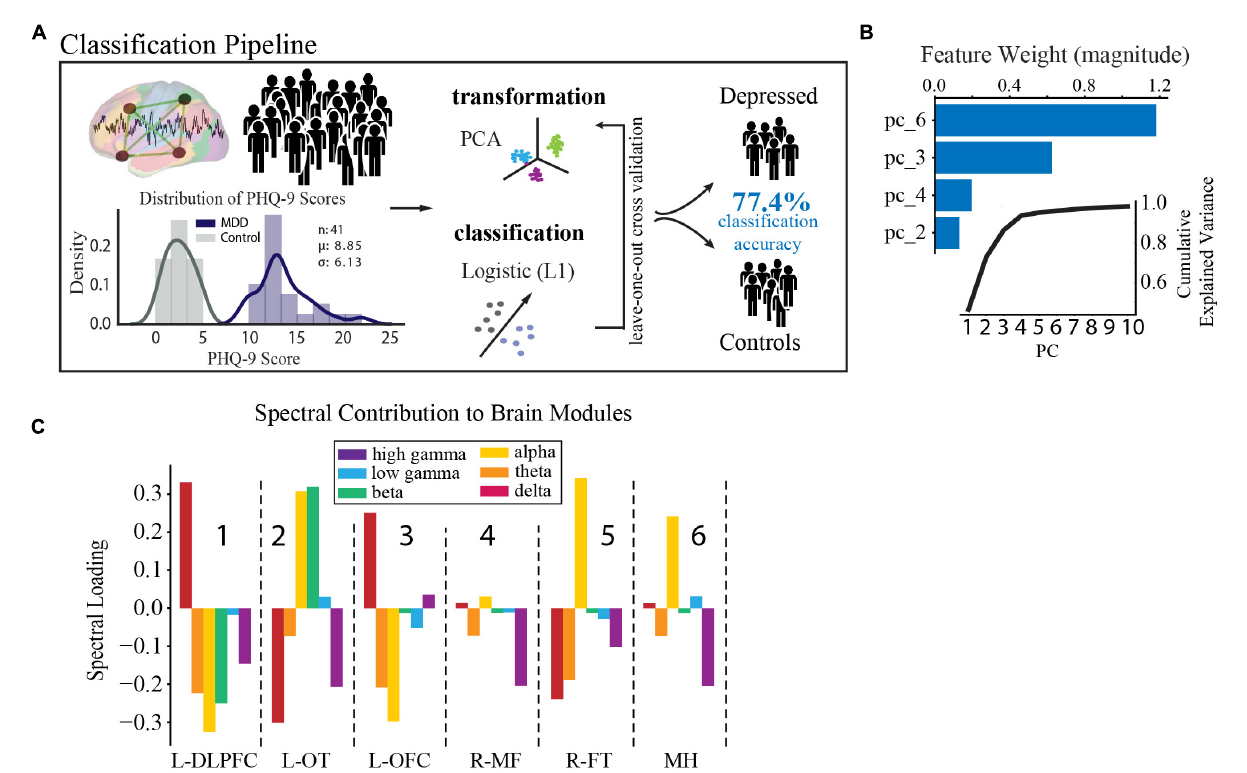
FIGURE 4 | Spectral-spatial features that discriminate depression at group level. (A) Activity analysis pipeline showing steps including power feature extraction, dimensionality reduction, transformation, and classification. The distribution of PHQ-9 scores across the depression ( n = 18, purple) and control groups ( n = 23, gray) is shown bottom left (mean PHQ-9 score 8.85, standard deviation 6.13). Power was extracted from the reconstructed time-series using the Morlet transformation in 30 s intervals across 6 frequency bands (delta = 1–4 Hz, theta = 5–8 Hz, alpha = 9–12 Hz, beta = 13–30 Hz, low gamma (gammaL) = 31–70 Hz, high gamma (gammaH) = 71–150 Hz). This process yielded 25,464 spectral power features from our model (6 frequency bands × 4,244 electrodes × 2 h). Z-scored relative power was calculated and averaged within each band across each of the 6 network modules. Power was then further averaged across time to yield 36 spectral-spatial features per participant. Principal component analysis was then used to transform the full spectral-spatial feature set, followed by logistic classification yielding 4 features that identified depression with 80.0% accuracy on the training set and 77.4% on the test set. (B) The component weights of the four features with cumulative explained variance across the first 10 principal components shown in the inset. (C) Spectral distribution of the 4 components was obtained by calculating the dot product between the loading weights ( > 0.2) for each spectral-spatial feature in the four principal components and the coefficient weighting from the classifier. Bars show the direction of change of each power band and module in relation to depression diagnosis and relate changes in spectral power associated with depression across spatially distributed brain networks. These spectral-spatial features represent the circuit activity that distinguishes depression